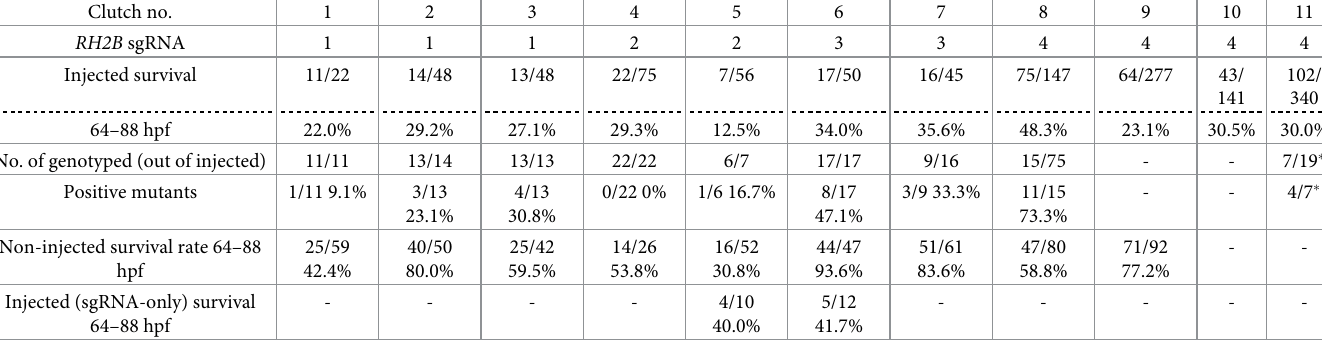
Table 1. Clutch survival and mutation rates for RH2B targeted injection rounds. Survival rates of embryos injected with sgRNA/Cas9 (treatment) or sgRNA-only (pos- itive control) targeting RH2B , and non-injected (negative control) embryos at time of collection (64–88 hpf), number of genotyped embryos, and mutation rate per clutch and target sequence. Note: Clutches 8–11 (sgRNA 4) were injected with a lower concentration of sgRNA/Cas9. Clutch no.